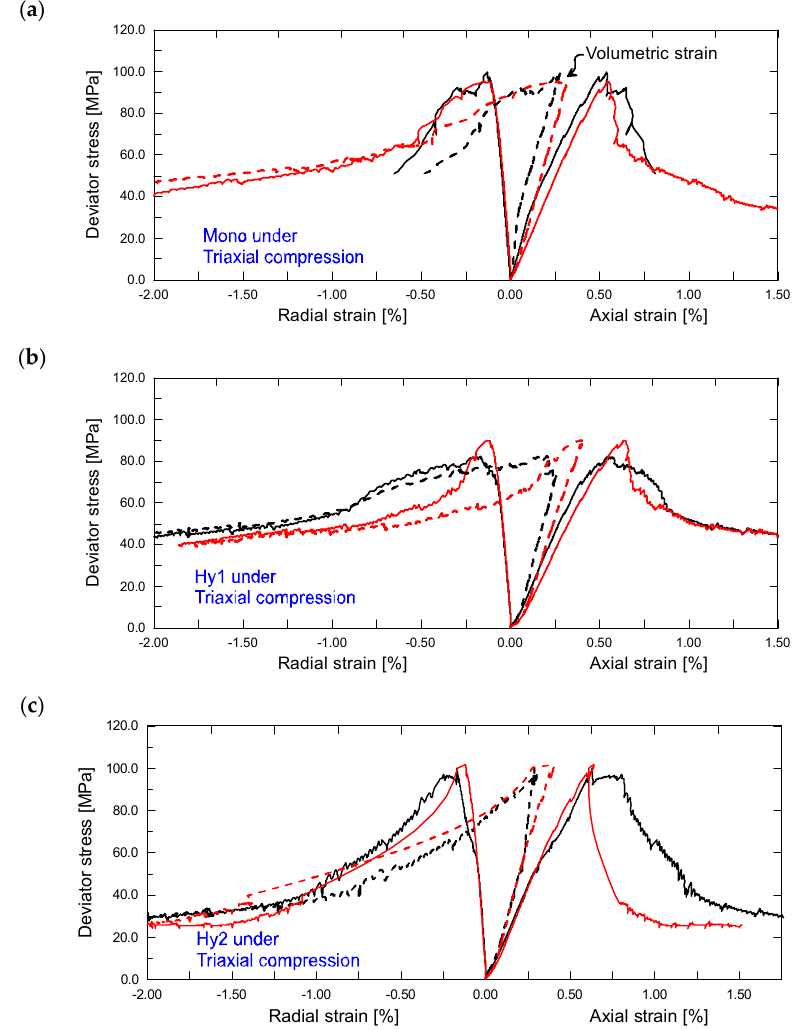
Figure 6. Stress–strain relations of ( a ) Mono, ( b ) Hy1 and ( c ) Hy2 mixtures under triaxial compression.